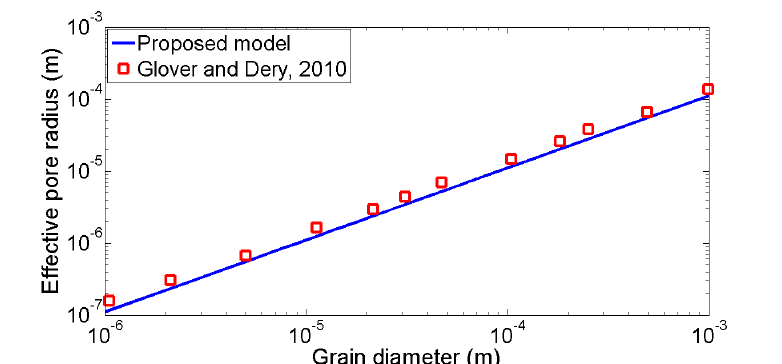
Figure 10. Comparison of measured and predicted effective pore radii for a range of glass bead packs reported by [76]. In the model: α = 0.025, φ and m are reported in [76], a = 8/3 and F = φ − m